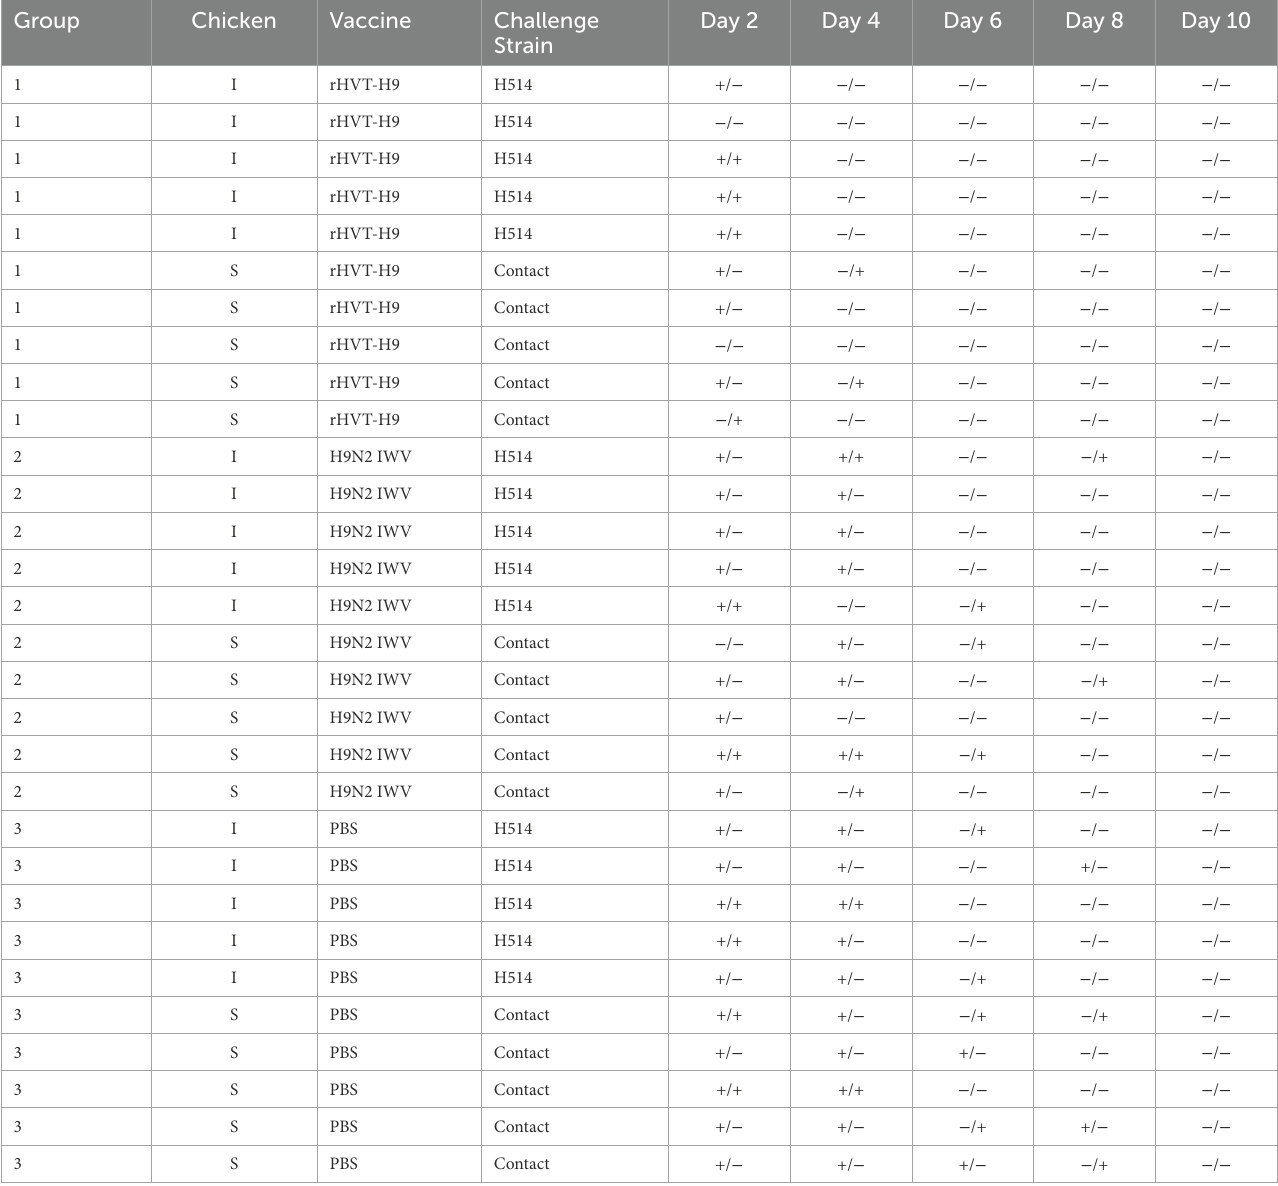
TABLE 3 Overview of transmission experiment results from Day 1 p.i until Day 10 p.i. Group